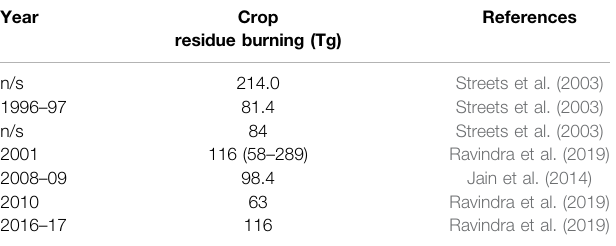
TABLE 4 | Comparative estimates of crop residue burning in